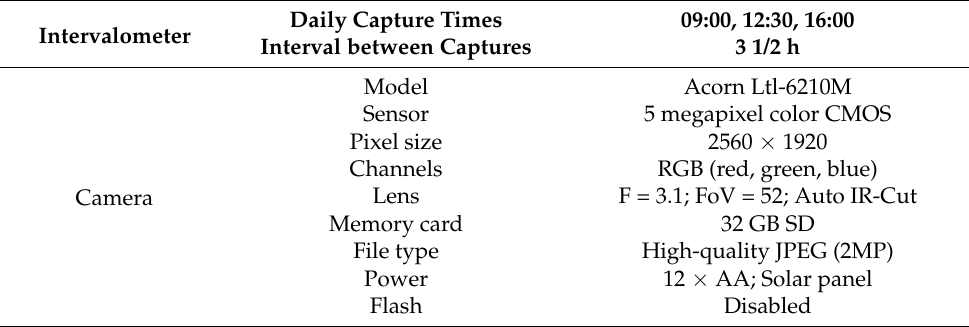
Table 3. Descriptions of the intervalometers and cameras employed. FoV : field of